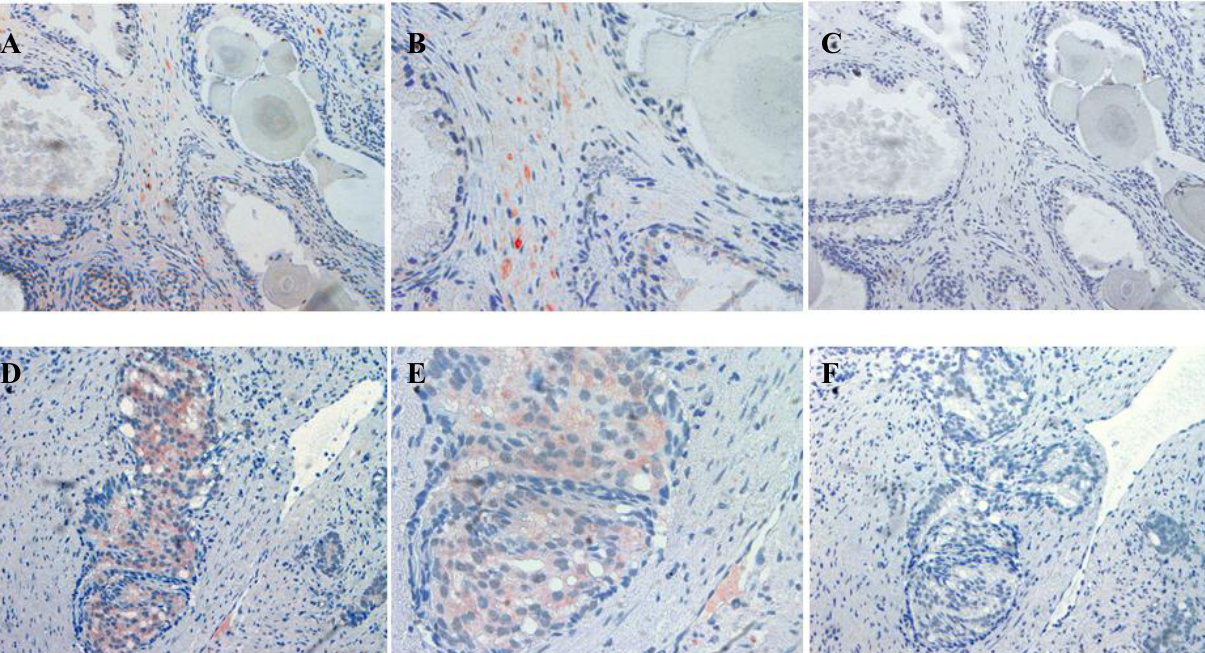
Figure 3. Immunolocalization of ATIP staining in stroma surrounding BPH ( A and B ) and HGPIN ( D and E ) gland in paraffin embedded tissue sections. Serial sections showing an absence of staining when the ATIP antibody was pre-absorbed ( C and F ) with ATIP antigen. Images were taken at ( A , C , D and F ) 200× and ( B and E ) 400× magnification.